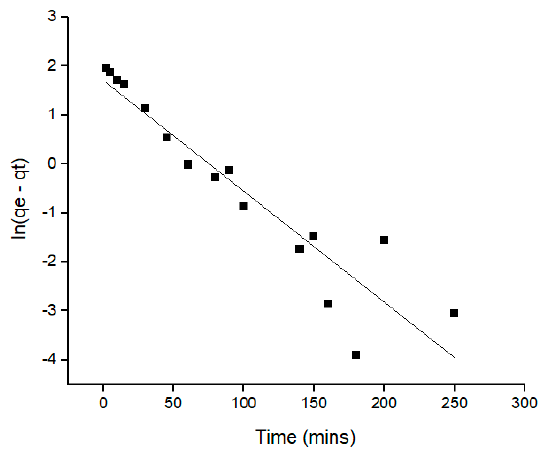
Figure 8. Pseudo-first order kinetic plots for the removal of Pb(II) ions onto Si-TS-SSIL.